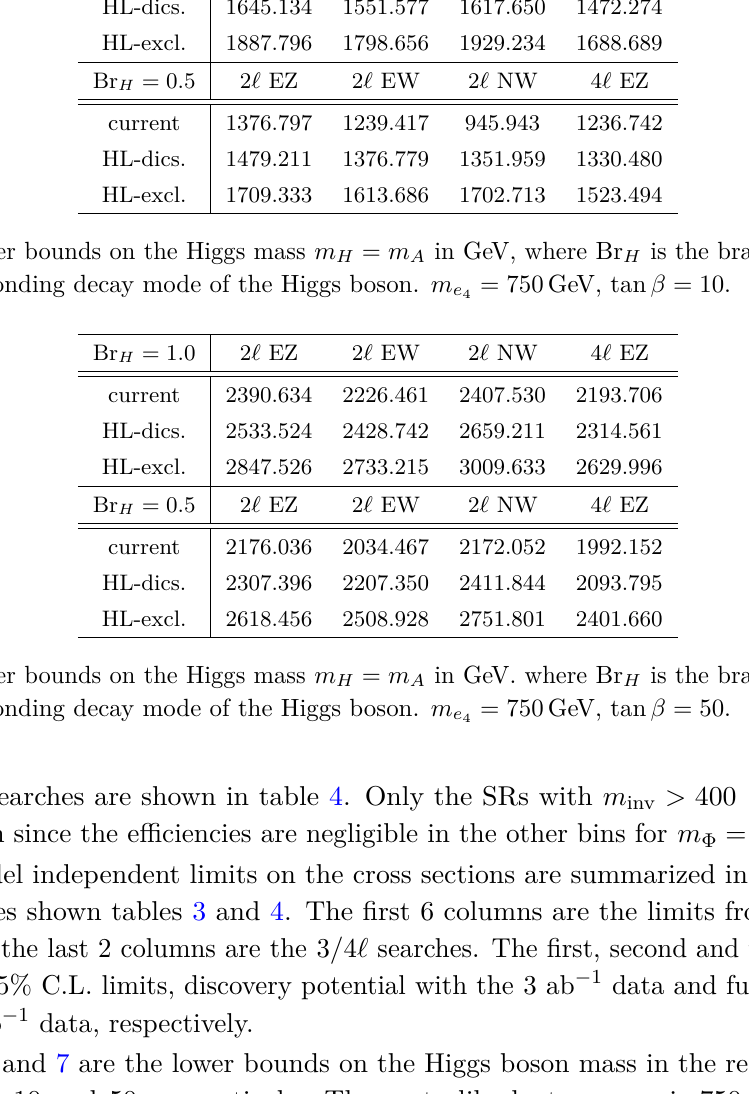
Br H = 1 . 0 2 ‘ EZ 2 ‘ EW